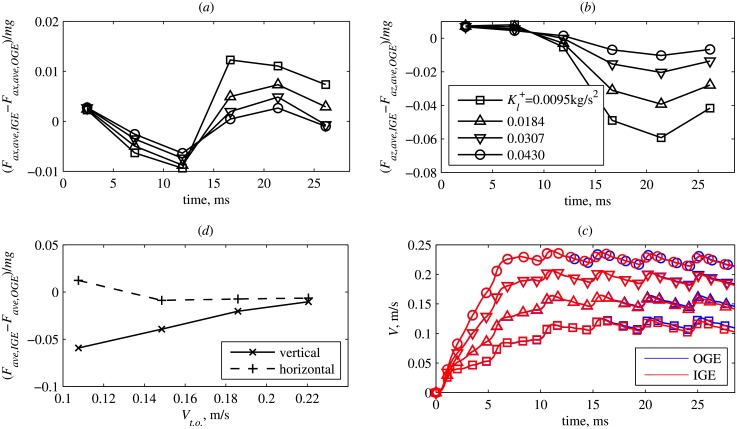
Takeoffs with simplified kinematics.(a) Horizontal and (b) vertical difference between the wingbeat-averaged force IGE and OGE, normalized to the insect weight. (c) Vertical velocity of the body point of reference (rate of climb) versus time. (d) Maximum normalized force difference versus takeoff rate of climb at the moment when the legs lose contact with the ground.